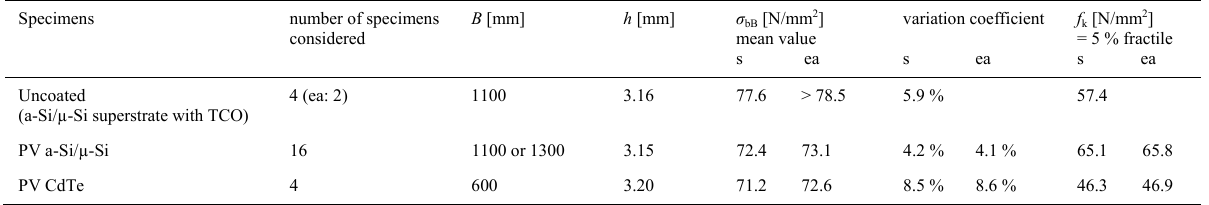
Table 8: Statistical evaluation of photovoltaic panes in four point bending. s: overall bending strength, ea: edge ablation area